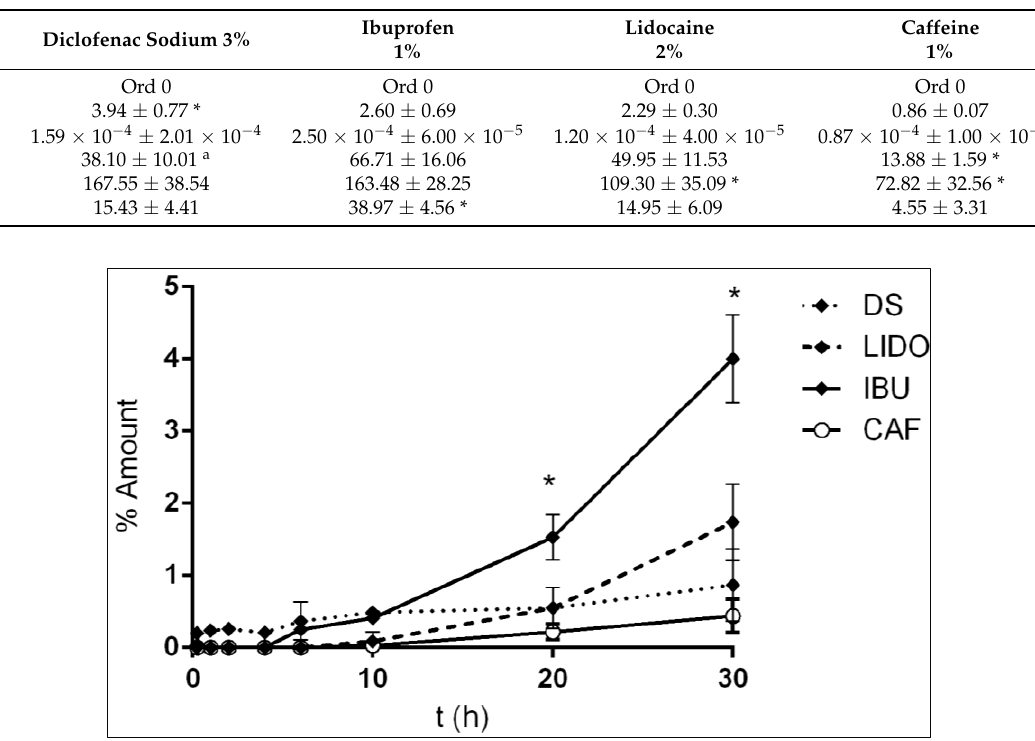
Figure 1. Mean percentage of release of diclofenac sodium, lidocaine, ibuprofen, and caffeine applied at an infinite dose (* indicates significantly different, p < 0.05).